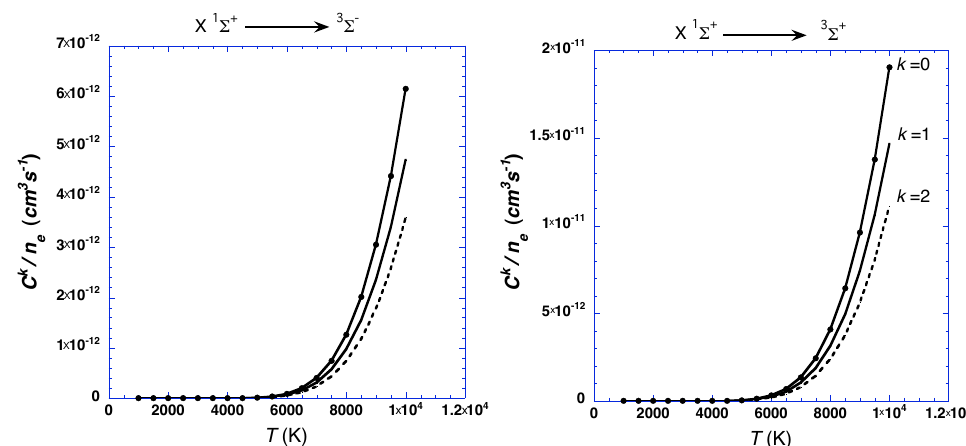
Figure 1. Inelastic rates C k due to isotropic collisions with electrons for 1000 K ≤ T ≤ 10,000